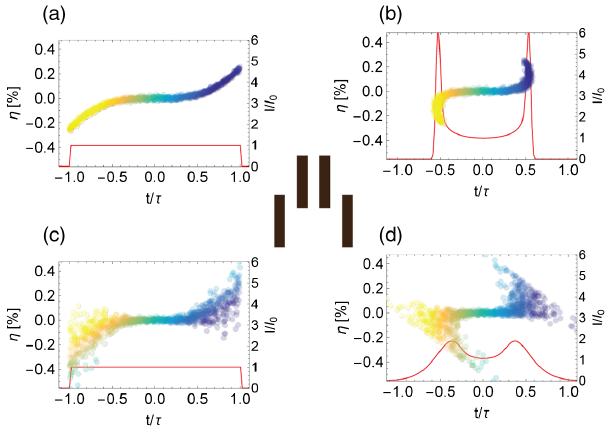
FIG. 9. Cartoon illustrating heater horn suppression. From (a) to (b) a chicane compresses a beam with cubic chirp forming a caustic. From (c) to (d) the same caustic is suppressed due to energy spread from a laser heater. Particles in frame (a)[b] are colored by final t coordinate from (b)[d] such that we can see which parts of the initial phase space lead to the caustic. Current profiles are shown in